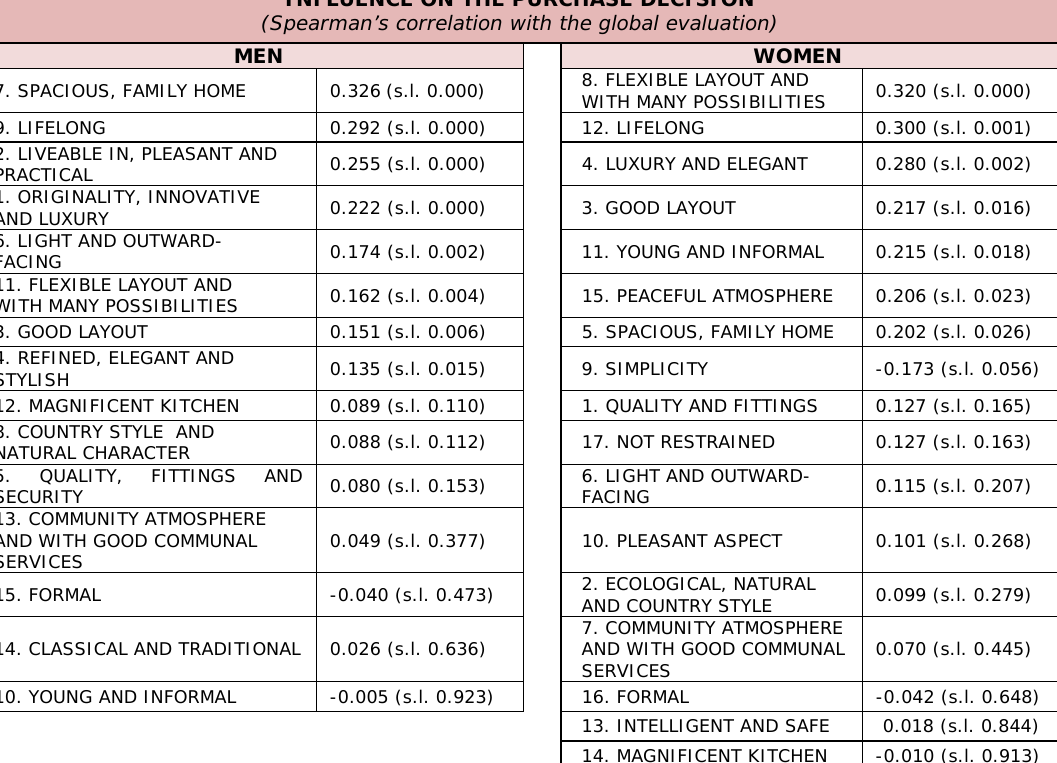
Table 6. “Range Factor ordering according to influence on the purchase decision”. Source: